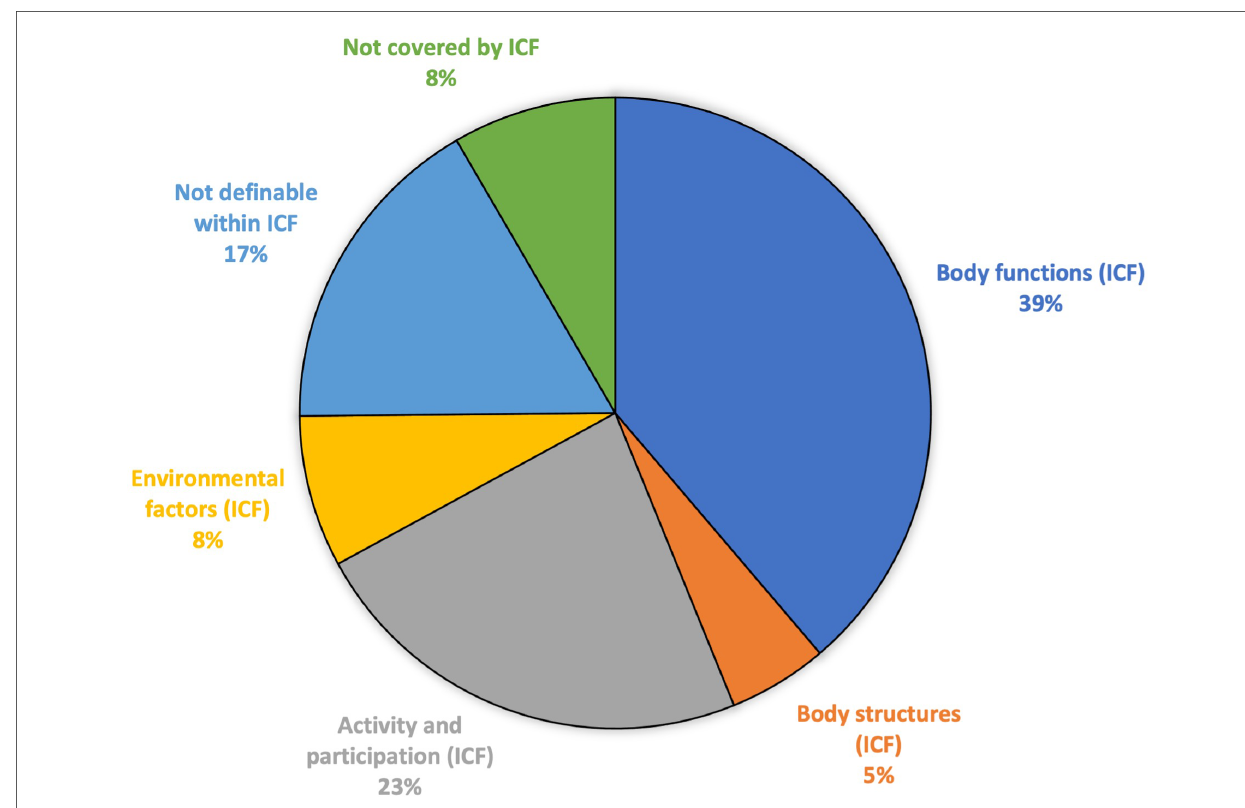
FIGURE 3 Result of the ICF linking of sick leave certi fi cates issued for long-term musculoskeletal pain, in terms of the number of codings of ICF categories and other health information not possible to link to